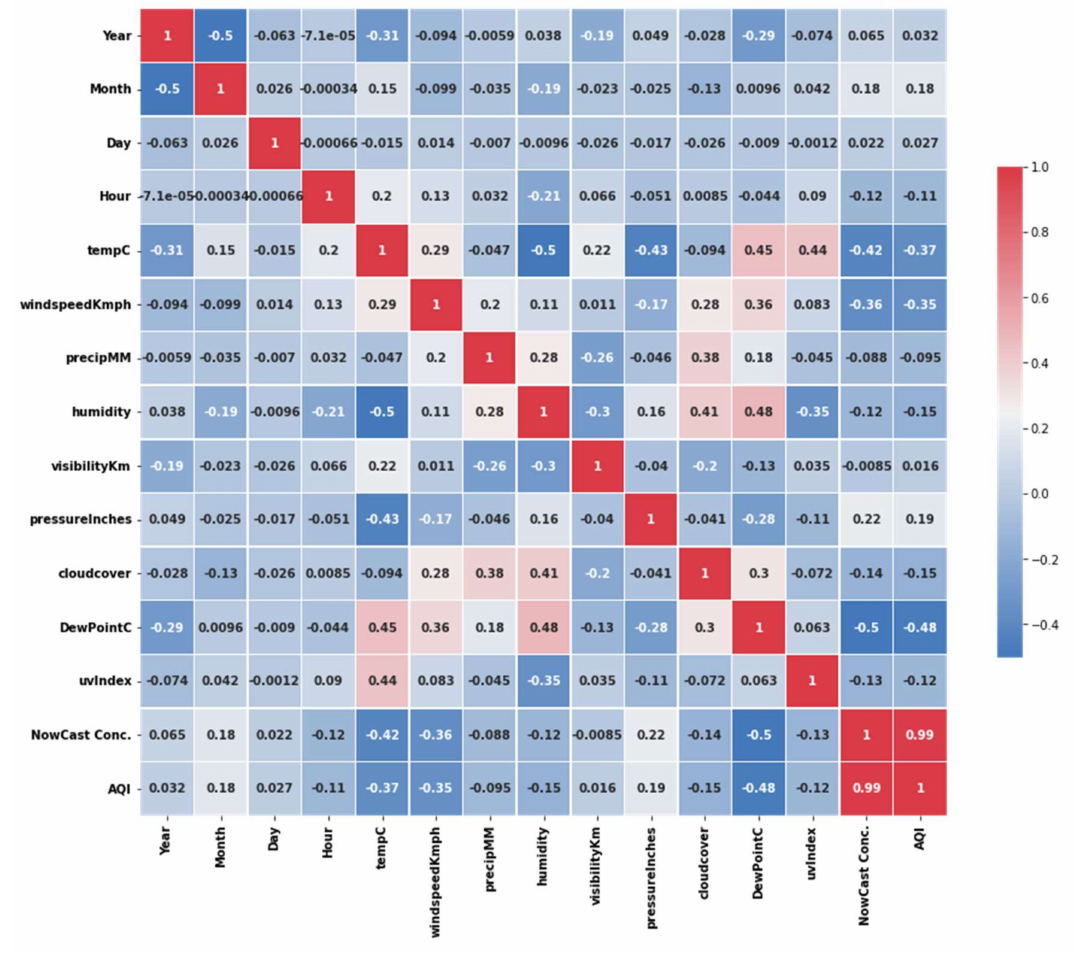
Figure 6. Depiction of the daily distribution of PM 2.5 concentrations according to EPA standards for Lahore.